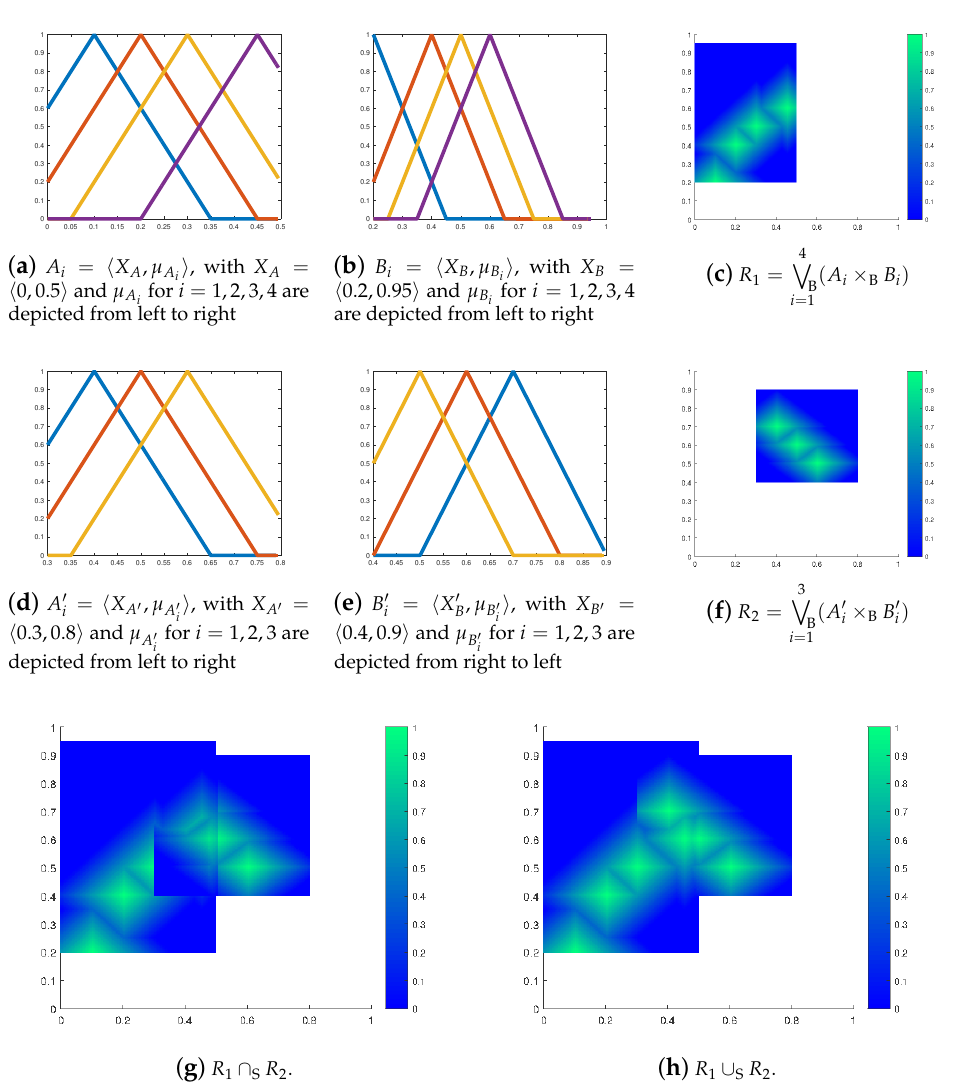
Figure 5. Examples of partial fuzzy relations from Example